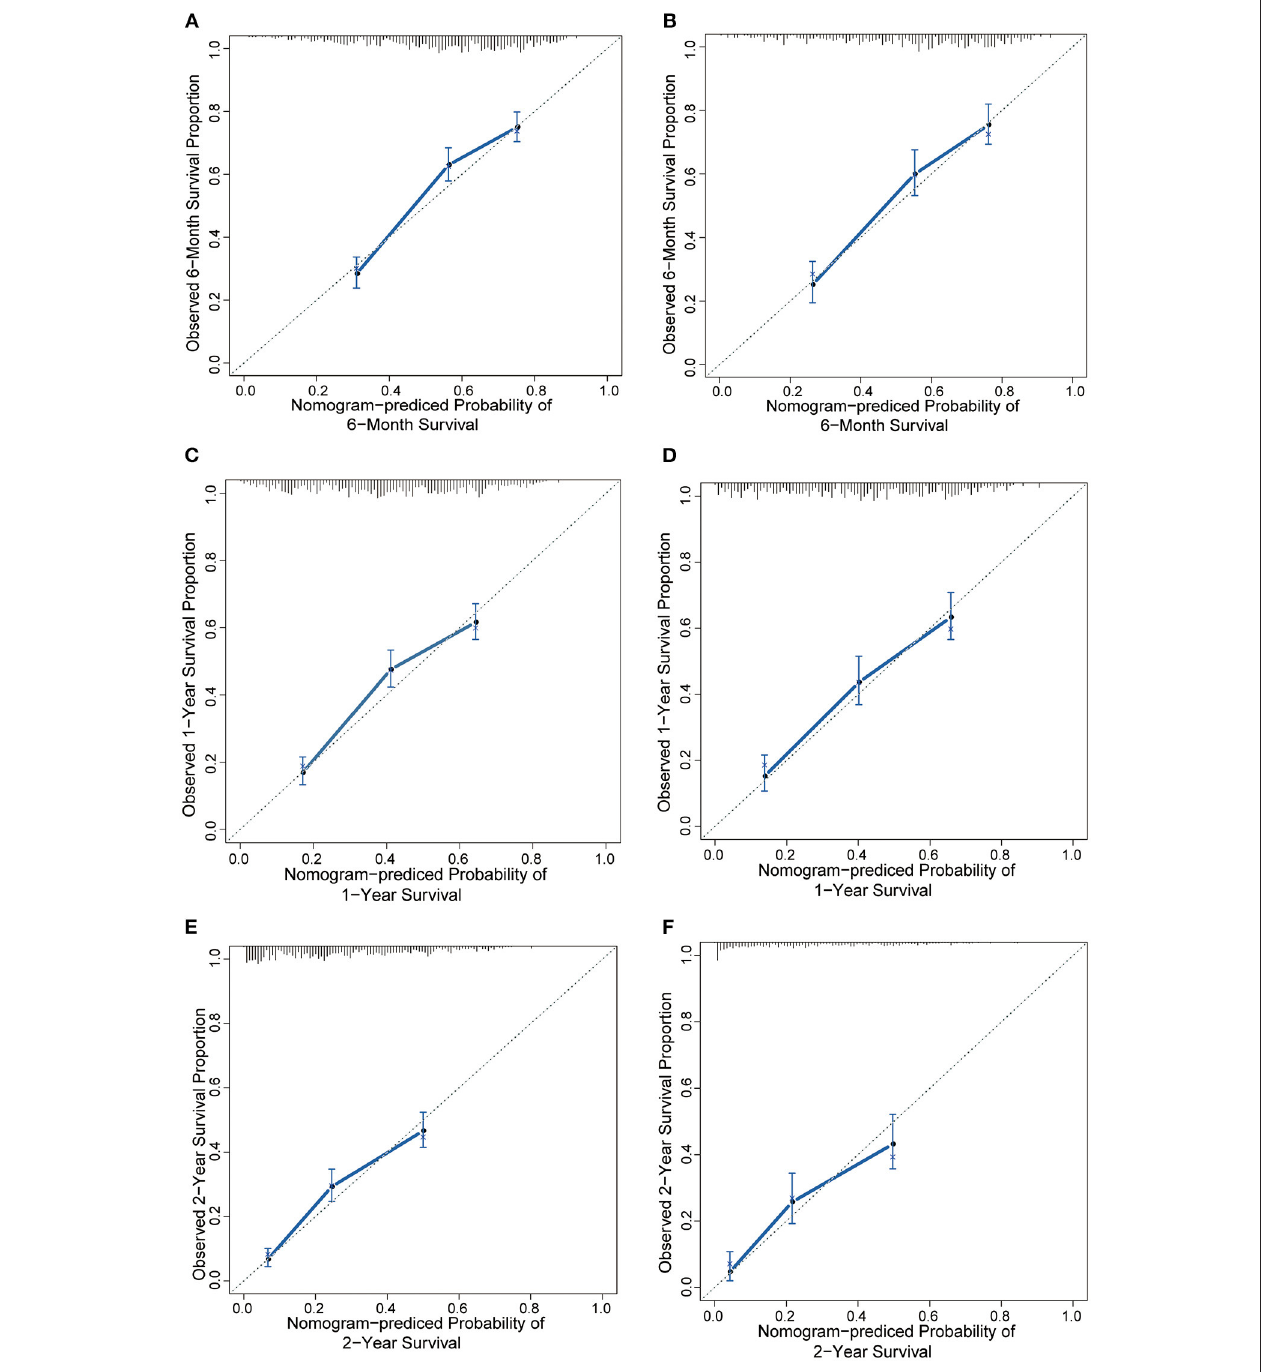
FIGURE 2 | The calibration curve for predicting patient survival at (A) 6 months, (C) 1 year, and (E) 2 years in the training cohort and at (B,D,F) 6 months, 1 year, and 2 years in the validation cohort. Nomogram-predicted probability of overall survival is plotted on the x-axis; actual overall survival is plotted on the